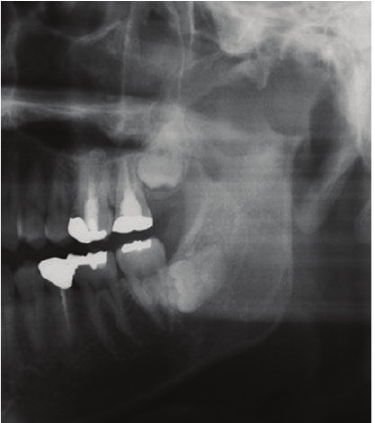
Figure 2: Bone resorption from left fossa to condyle in panorama radiograph.